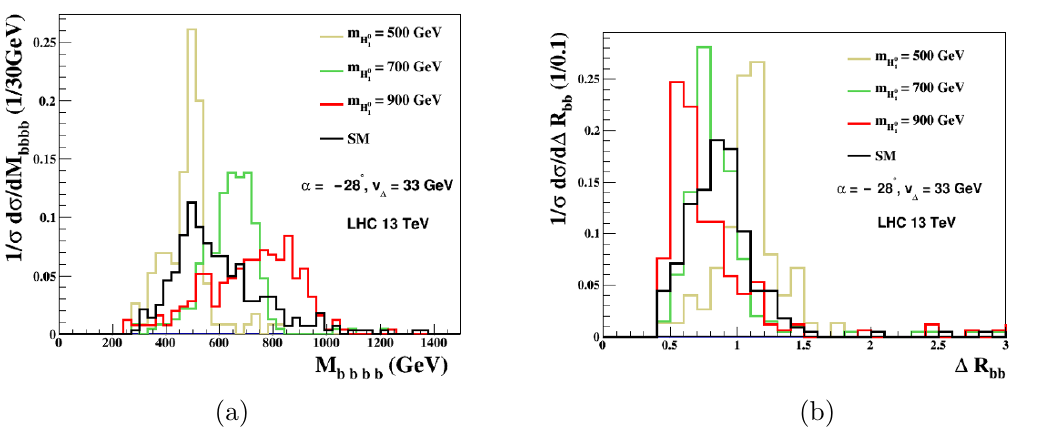
Figure 6 . Kinematic distributions for the 4 b channel in (a) the invariant mass M bbbb and (b) the opening angle (cid:1) R bb of the second and third energetic b jets after the preselection cuts for benchmark point G with di(cid:11)erent m in comparison with the SM expectations at the 13-TeV LHC. H 0 1